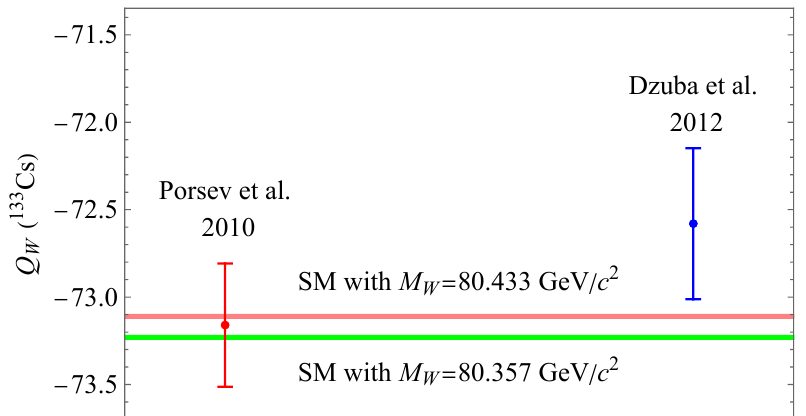
Figure 1. (Color online) Comparison between the 133 Cs nuclear weak charge as predicted by the Standard Model (SM) with the mass of the W boson being M W = 80.357GeV/c 2 [82] (blue band), the SM with M W = 80.433GeV/c 2 [33] (pink band), and 133 Cs APV experiment [1] with different calculations for the 133 Cs atomic structure factor (red and blue